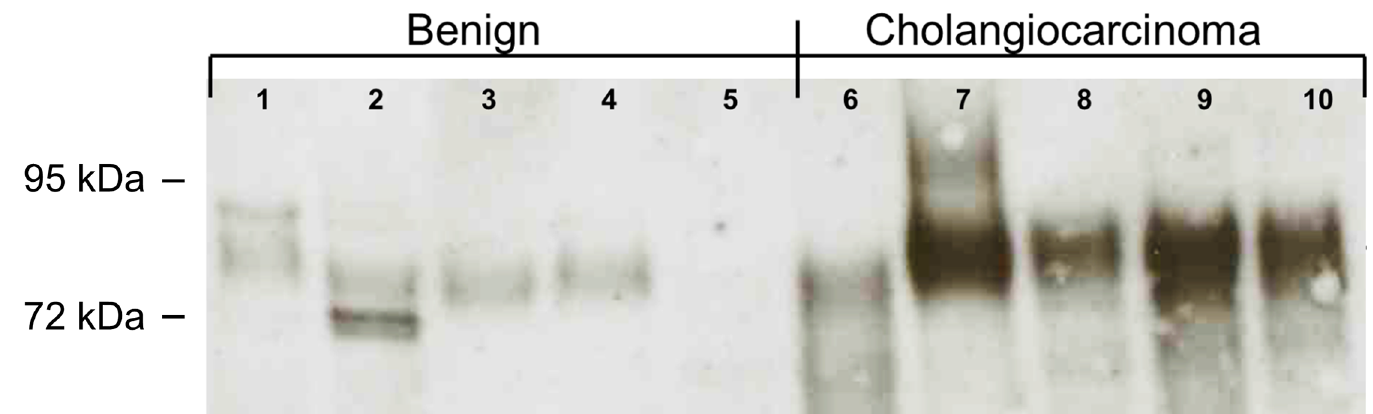
Fig 1. Qualitative Western Blot analysis of bile from patients with benign and malignant disease. The Western Blot analysis utilizes the detection antibody provided in the commercial ELISA kit used in these experiments. The 90kDa CEACAM6 is detected between the 95kDa and 72kDa protein ladder bands.